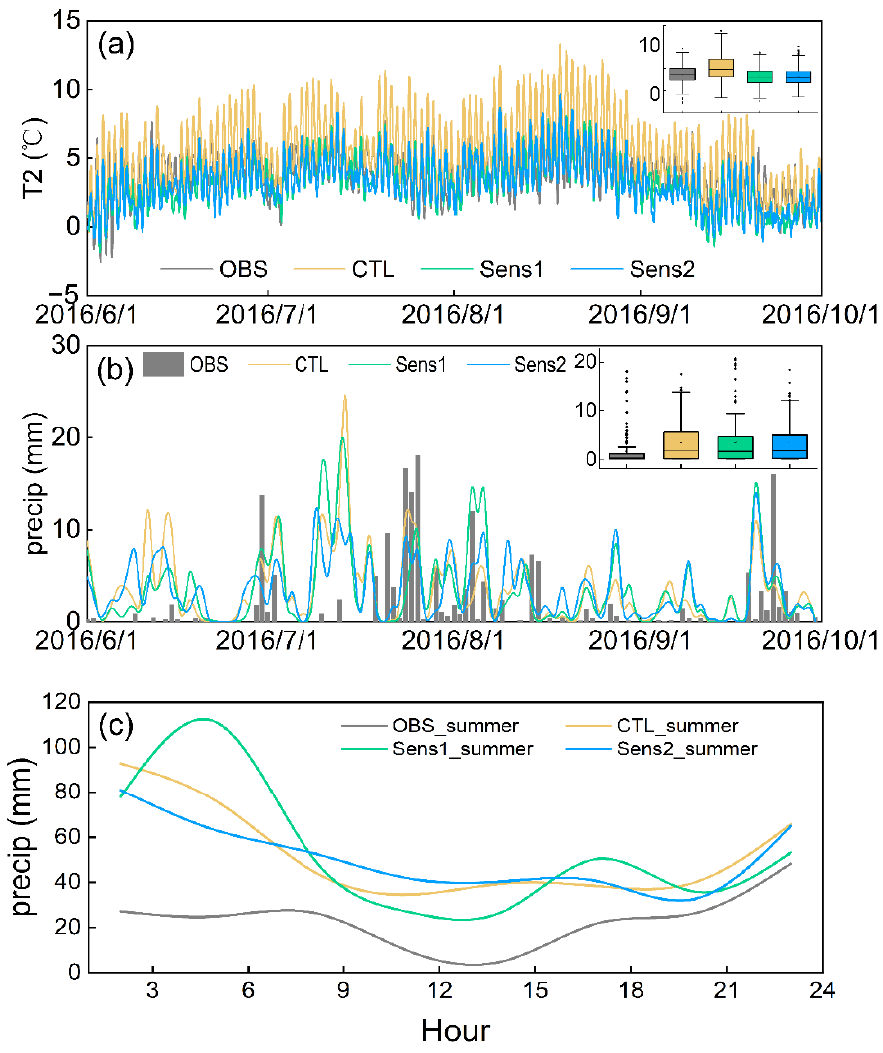
Figure 2. Observed and modeled ( a ) 2 m air temperature (T2), ( b ) daily rainfall, and ( c ) accumulated diurnal variation of rainfall in the ablation zone over the Parlung No. 4 Glacier, with a box whisker diagram in the upper right corner.